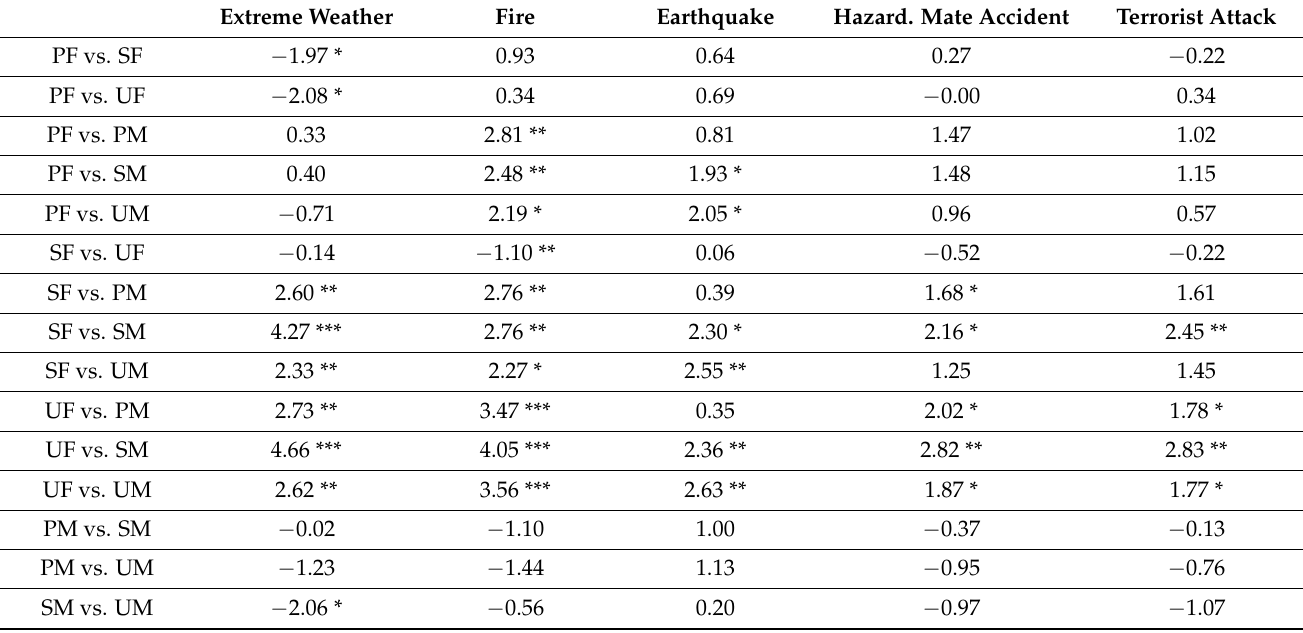
Table 13. Results of pairwise comparison using Dunn’s test (z-statistic and p -values) for risk percep- tion according to gender and education background ( α = 0.05).